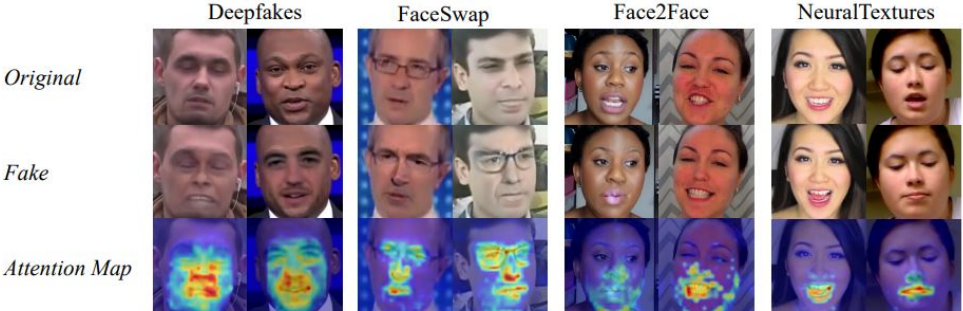
the specific regions of face. The original row contains the original face image. Second row is a set of manipulated face samples picked at random from the FF++ [47] testing set. And last row shows that the attention maps of manipulated face samples. DeepFakes, FaceSwap, Face2Face, and NeuralTextures columns are the four manipulation methods.